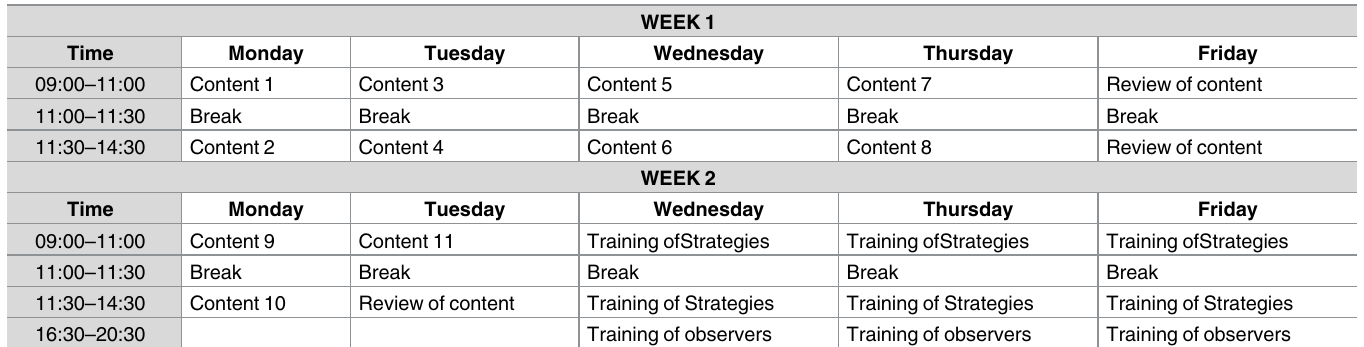
Table 1. Organisation of the